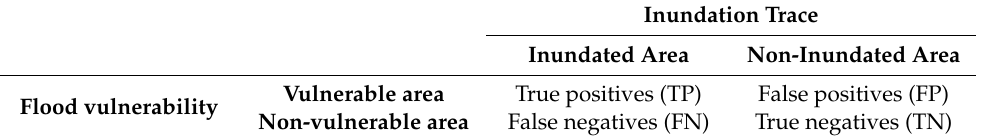
Table 3. Overview of 2 × 2 confusion matrix.